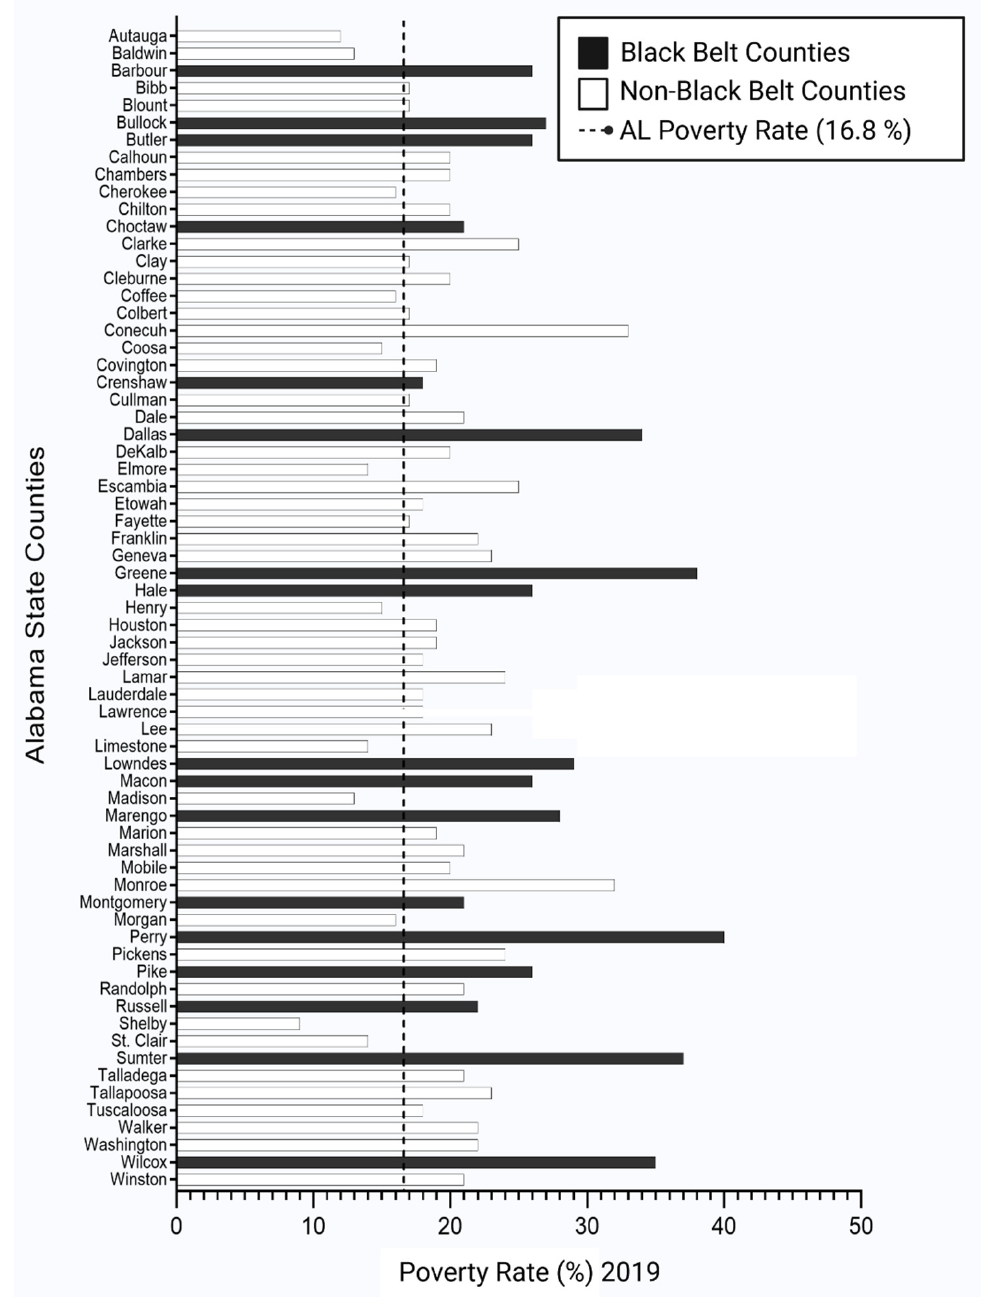
Figure 3. The poverty rate of each county in Alabama (2021). The state-level poverty rate is 16.8 percent (2021). Out of 67 counties in Alabama, 17 are considered Black Belt counties, where most of the population is African American communities. The socioeconomic disparity is so apparent that all 17 Black Belt counties have a higher poverty rate than the state poverty rate. Most importantly, the top 10 poverty counties in the state are recognized from the Black Belt region. The deprived SES enormously has influenced the health status of the people. Data source: U.S. Department of Census (2021) [25], accessed on 30 December 2021.